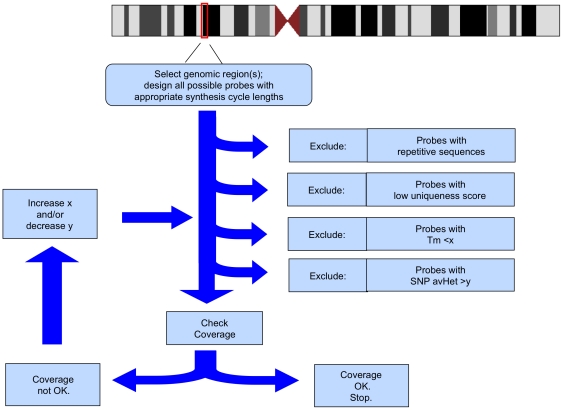
Proposed algorithm to refine probe selection.